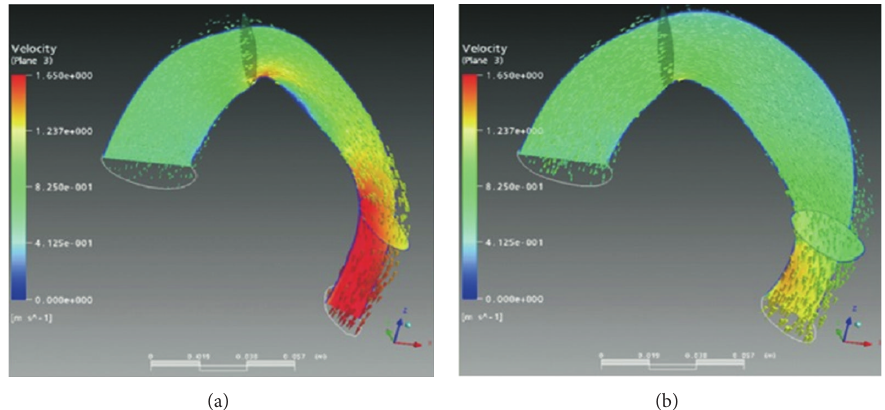
Figure 5: Model of fluid dynamics velocity and vector plot in a thoracic stent graft before (a) and after (b) remodeling. Adapted from Cheng et al.